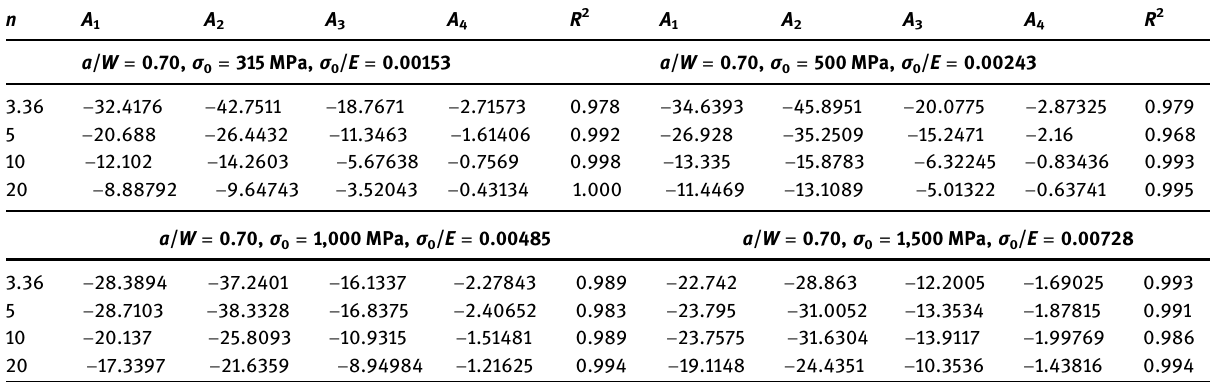
Table 14: Coe ffi cients of matching formula ( 33 ) to the numerical results for the estimation of the Q stress values, for SEN ( 4PB ) specimens dominated by the plane strain state, with the relative crack length a / W =